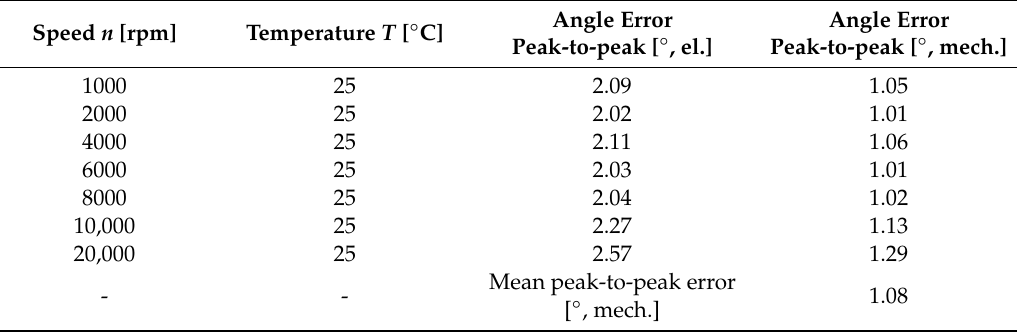
Table 6. Results of the speed variation test of Inductive Sample #4.